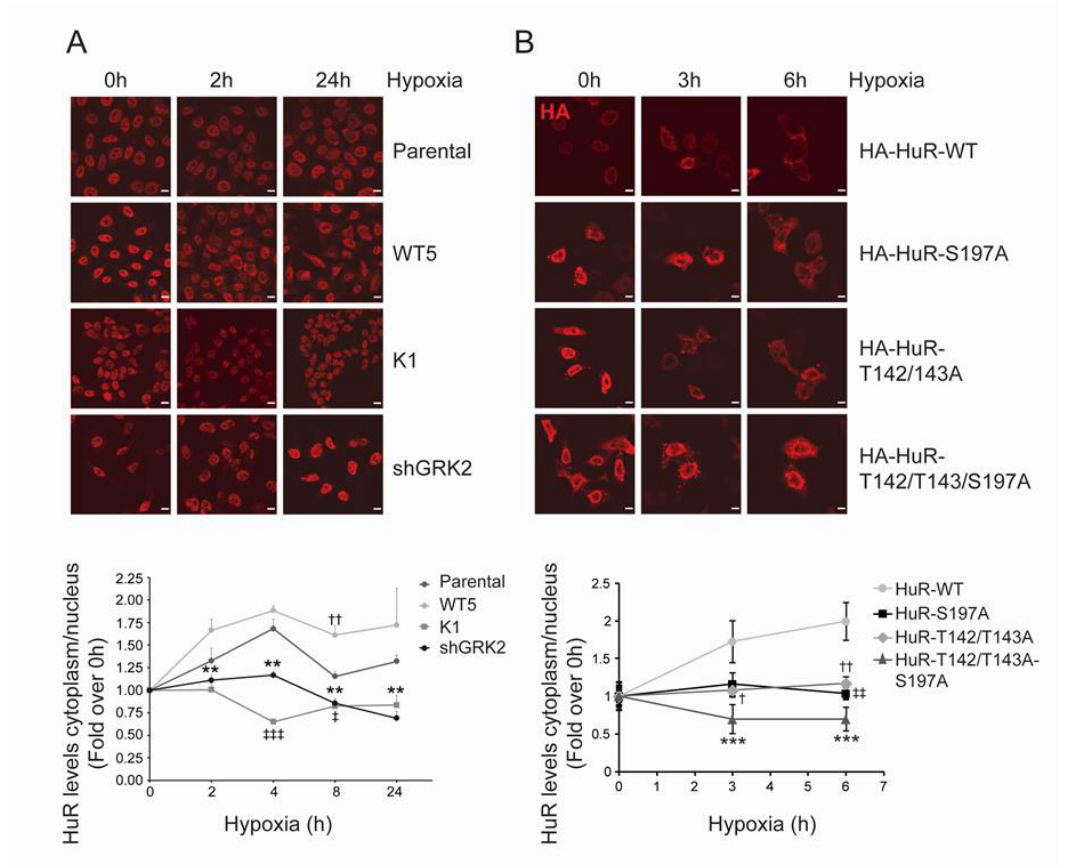
Figure 3. GRK2 affects hypoxia-dependent changes in HuR subcellular distribution. ( A ) The indicated HeLa stable cell lines were cultured under hypoxia, and HuR nuclear and cytosolic levels were analyzed by immunofluorescence, at the indicated times. Values are mean ± SEM from 3–4 independent experiments. †† p < 0.01 wt5 vs. parental; ‡ p < 0.05 ‡‡‡ p < 0.001 K1 vs. parental; ** p < 0.01 shGRK2 vs. parental (Student’s t -test). Representative images are shown. Scale Bar = 10 µm. ( B ) HeLa cells were transiently transfected with HA-HuR WT, HA-HuR-S197A, HA-HuR-T142/143A, or HA-HuR-T142/143A-S197A, and was cultured under hypoxia for the indicated times. Localization of HA-tagged HuR was assessed by immunofluorescence and the nuclear and cytosolic levels were quantified. Values are mean ± SD from two independent experiments. ‡‡ p < 0.01 S197A vs. wt; † p < 0.05 †† p < 0.01 T142/142A vs. wt; *** p < 0.001 T142/143A-S197A vs. wt; (two-way ANOVA). Representative images are shown. Scale Bar = 7 µm.